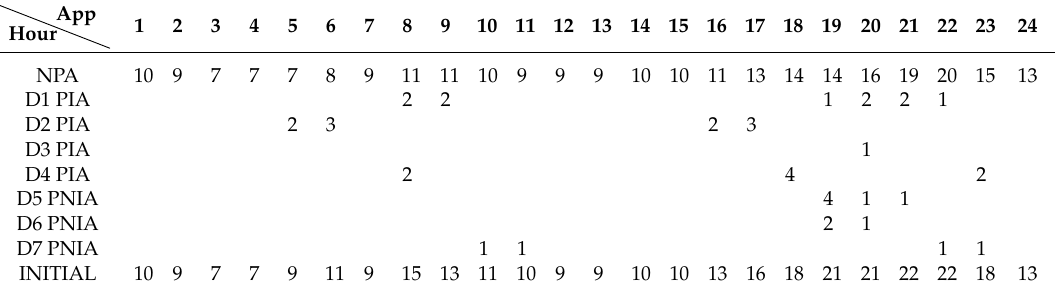
Table 2. Initial consumption schedule.